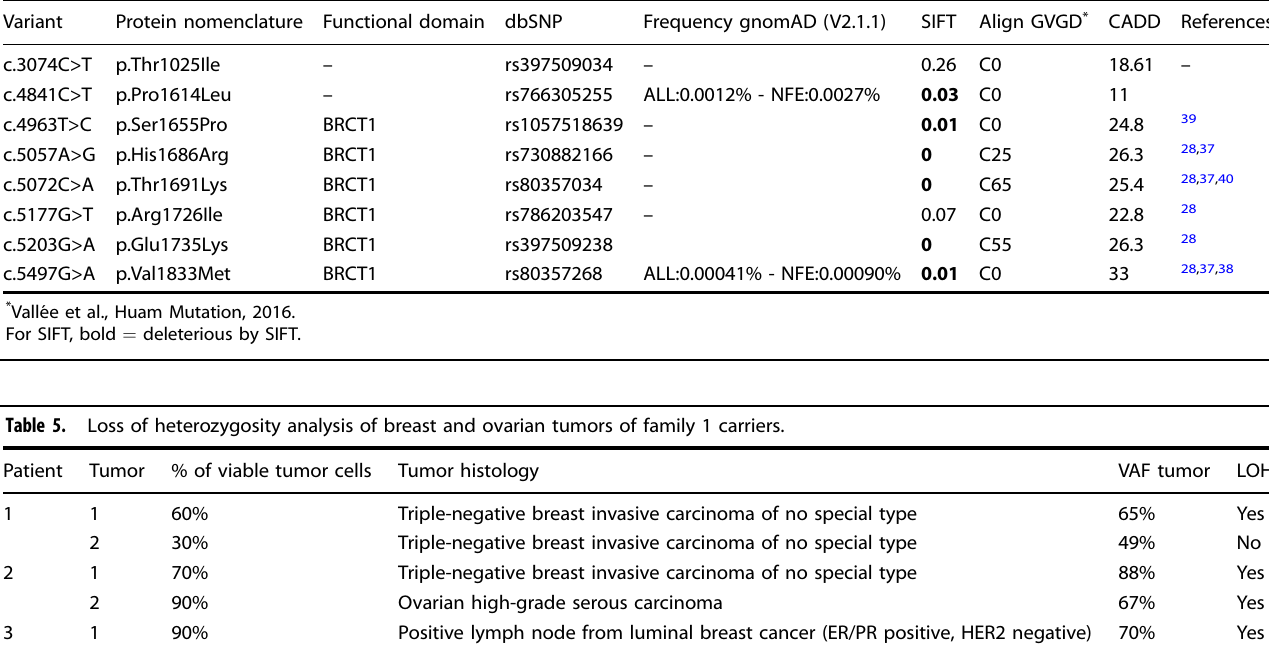
Table 4. Available evidence about the VUS analyzed in this study MS = missense; C-E: Evidence of pathogenicity of the unclassi fi ed variant BRCA1